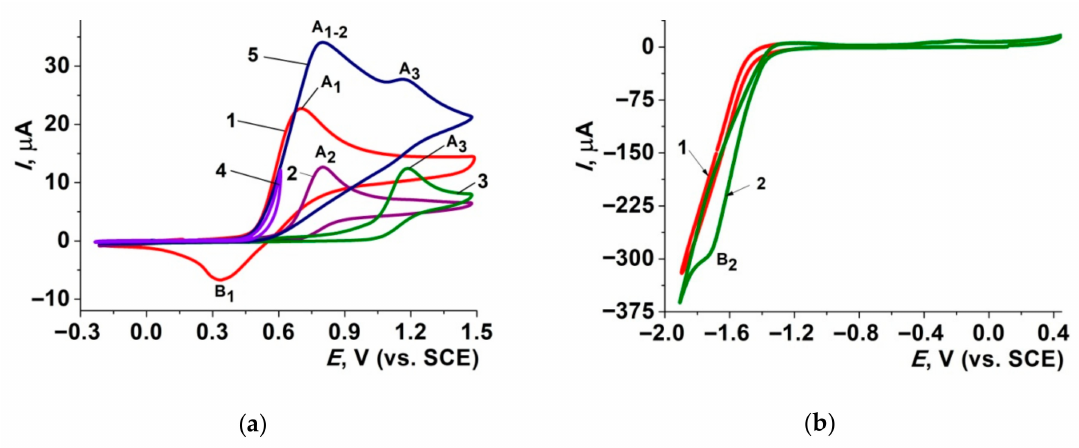
Figure 1. Cyclic voltammetry (CV) curves on Pt working electrode in 0.1M NaClO 4 in MeCN, ν